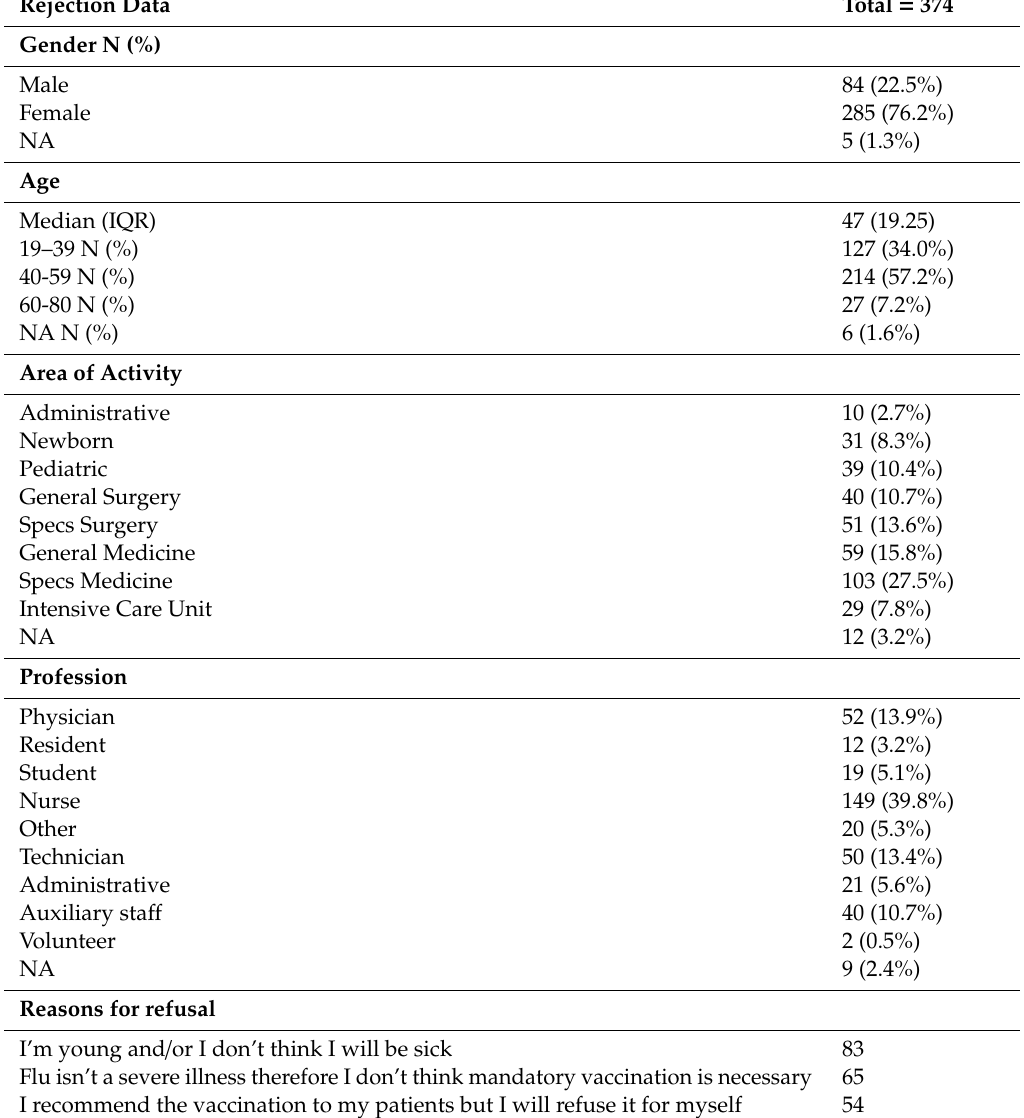
Table 6. Reasons for refusal (year